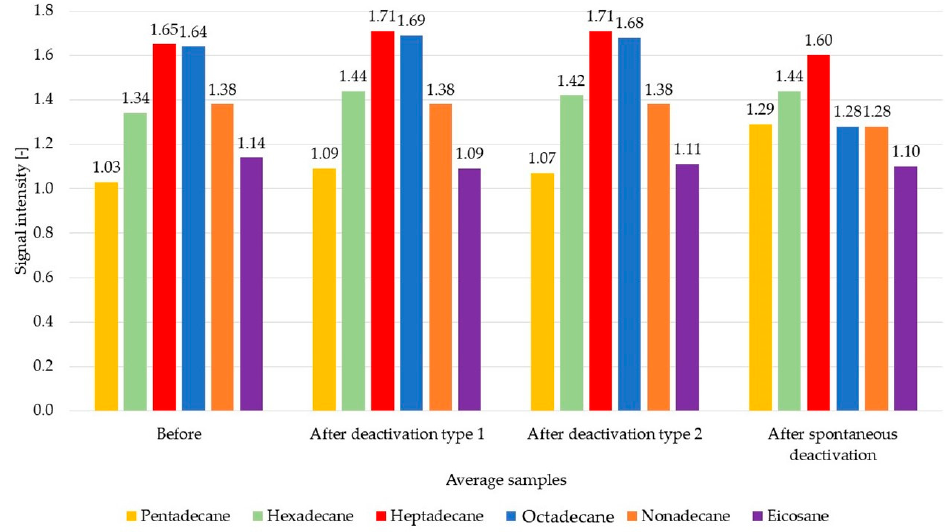
Figure 17. Occurrence of selected alkanes in average samples.